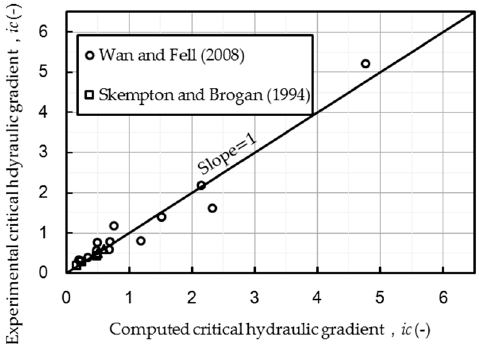
Figure 11. Comparison between computed critical hydraulic gradient and experimental critical hydraulic gradient.